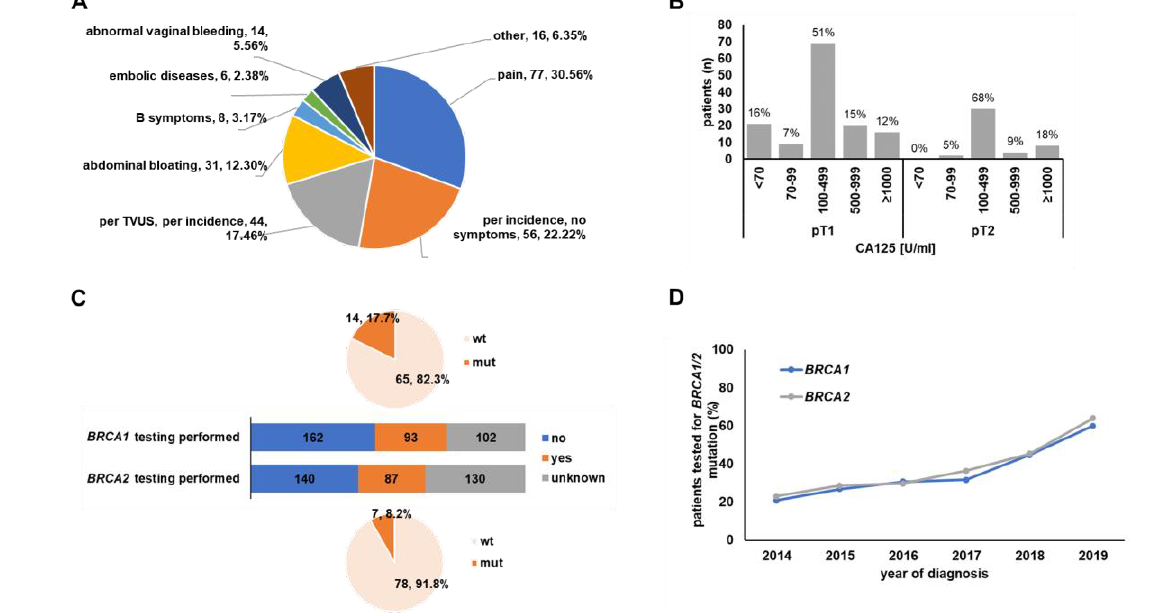
Figure 2. Diagnostics. Prevalence of symptoms is shown in pie chart ( A ). Distribution of CA125 blood levels as split up by pT stage is depicted in bar chart ( B ). Stacked bar charts in C show BRCA1 and BRCA2 testing rates. Fraction of patients that underwent BRCA1 or BRCA2 testing is marked in orange, while those within the blue fraction were documented to have not undergone BRCA testing. Whether BRCA testing was performed at all was unknown (not documented) for patients represented by the grey bars. Small pie charts in ( C ) depict BRCA1 /2 mutation frequency ( BRCA1 upper pie, BRCA2 lower pie) relative to the cases with known test result of BRCA1 /2 analysis, respectively. Testing rates for both BRCA1 and BRCA2 increased over time ( D ). TVUS = transvaginal ultrasound; wt = wildtype; mut = mutant.